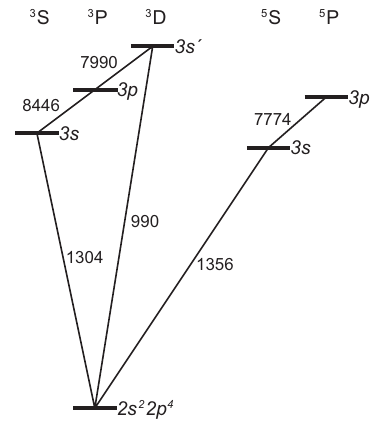
Fig. 2. Energy diagram of the lowest triplet and quintet states of atomic oxygen, showing the important transitions (labelled in